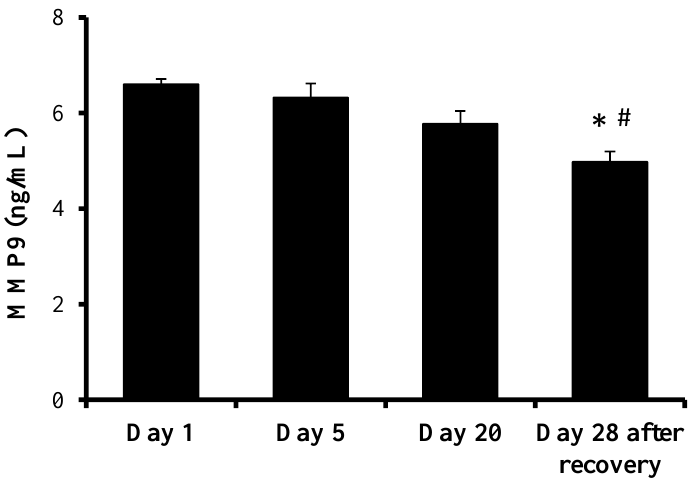
Figure 3. MMP9 plasma levels following HBOT sessions 1, 5, 20 and 28 (days) after wound recovery. The effects of the HBOT sessions were evaluated by a one-way ANOVA. p < 0.05; * indicates significant differences with respect to session 1; # indicates significant differences with respect to session 5. Abbreviation: MMP9, matrix metallopeptidase 9.